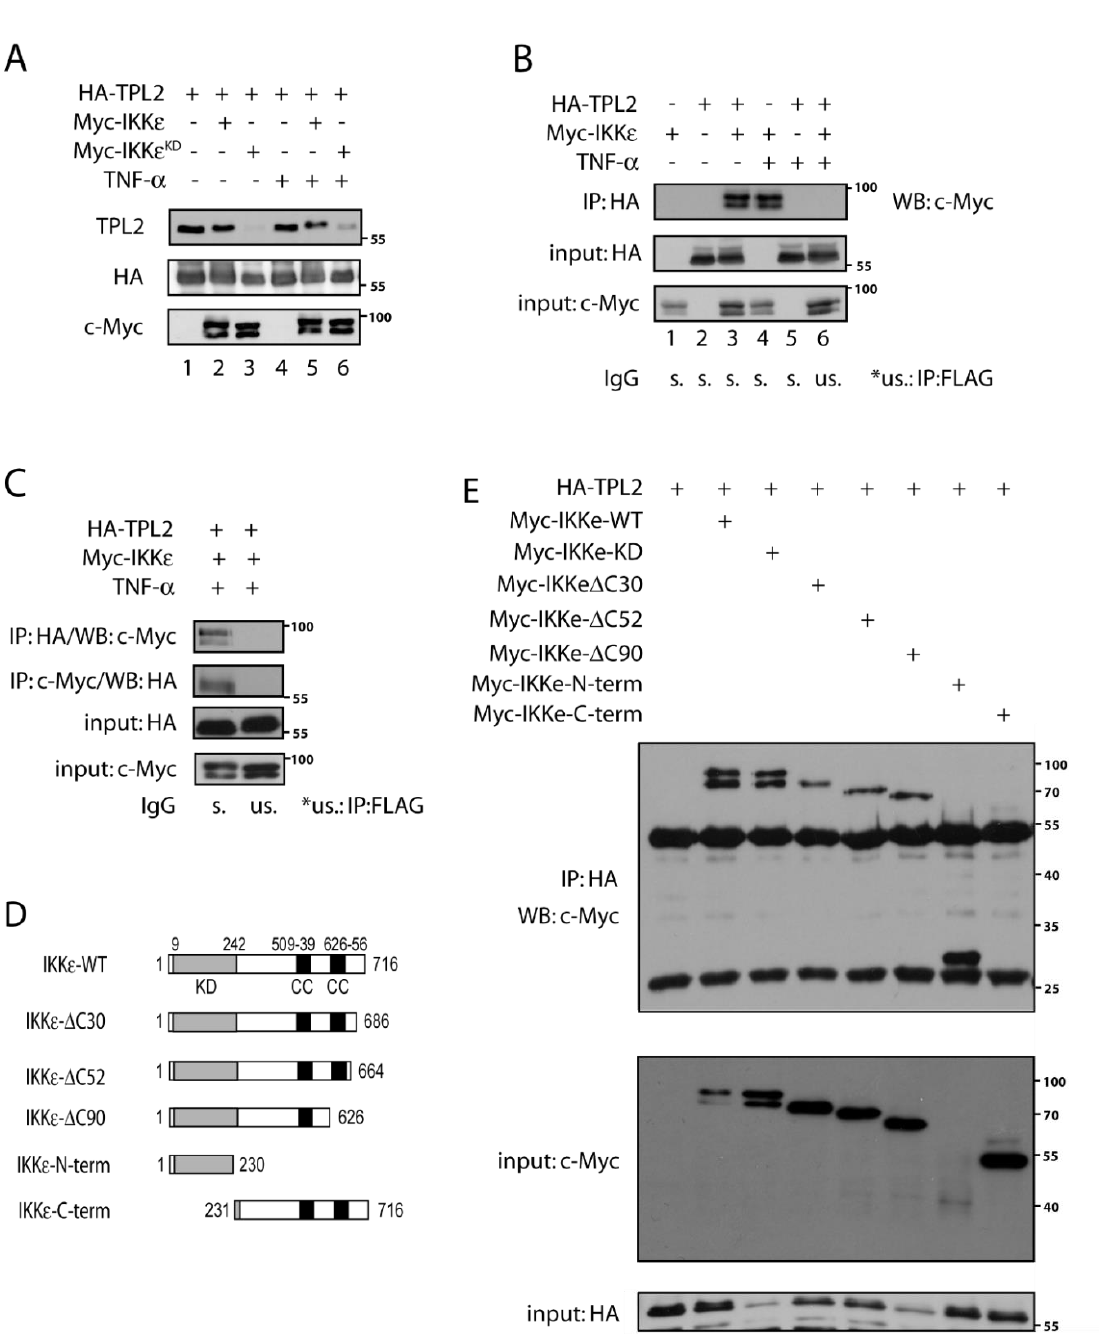
Figure 3: IKBKE interacts with MAP3K8 and their interaction is dependent on IKBKE kinase do- main (N-terminal). (A) HA-TPL2, Myc-IKKɛ or Myc-IKKɛ-KD containing plasmids were ectopically ex- pressed in HEK293 cells which are further stimulated 1 hour with 20 ng/ml TNF for IKKɛ/TPL2 activation. Then, protein samples were examined with WB by the help of indicated antibodies. (B) HEK293 cells were transfected with plasmids containing HA-TPL2 or Myc-IKKɛ constructs as indicated in the figure. Also, cells were stimulated 1 hour with 20 ng/ml TNF for IKKɛ/TPL2 activation. Then HA-TPL2 proteins were immunoprecipitated (IP) by the help of anti-HA antibody and co-immunoprecipitated IKKɛ is mon- itored by WB using the anti-Myc antibody. ( C ) With the same setting as before, a reciprocal IP experi- ment is carried using both anti-HA and anti-Myc precipitated proteins. ( D ) A sequence map showing different IKKɛ constructs which were used in further experiments for the identification of the IKKɛ domain required for the binding to TPL2. ( E ) HEK293 cells were transfected with different Myc-IKKɛ constructs (IKKɛ-WT, IKKɛ-KD, IKKɛ-ΔC30, IKKɛ-ΔC52, IKKɛ-ΔC90, IKKɛ-N-term, IKKɛ-C-term) and HA-TPL2, as indicated in the figure. Then, an IP experiment was carried on each sample using the anti-HA antibody and interacting IKBKE constructs were identified by